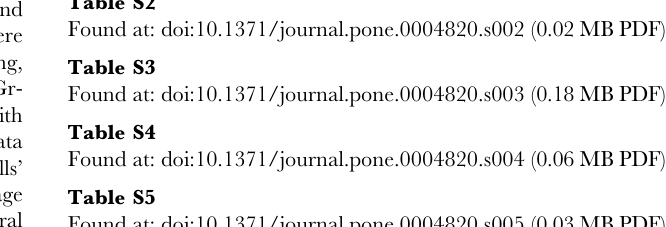
Figure S1 Effect of HOXB4 expression in generation of CFU- nmEM and surface marker expression. (A) Data show colony formation by 1,000 cells derived from EB. 1,000 cells were obtained from EBs on days 0, 2, 4, 5, 6, and 7 of culture and co- cultured with OP9 cells for 4 days. Cells collected from the co- cultures were plated in methylcellulose. HOXB4 expression was (HOXB4-off), turned on in both (HOXB4-on), or turned on only in OP9 co-cultures (HOXB4-on to -off). The number of